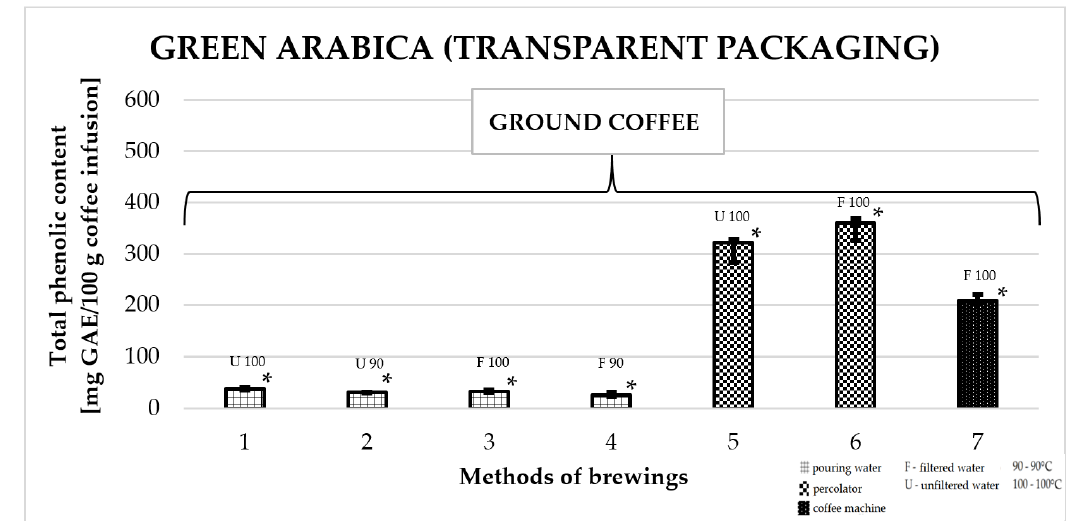
Figure 5. Total phenolic content as gallic acid equivalent [mg GAE/100 g of infusion] in 100% green Arabica coffee in transparent packaging. * p 1/2,4,5,6,7 ; * p 2/1,5,6,7 ; * p 3/5,6,7 ; * p 4/1,5,6,7 ; * p 5/1,2,3,4,7 ; * p 6/1,2,3,4,7 ; * p 7/1,2,3,4,5,6 —statistically significant differences (* p < 0.05). Preparation of the infusion: 1: pouring water,